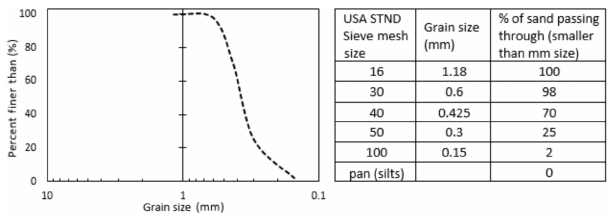
Figure 4. Characteristics and properties of the US Silica C778 ASTM graded